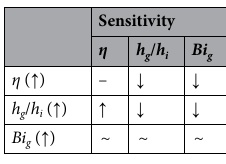
Table 3. Multi-parameter sensitivity analysis results for overall cooling effectiveness. ↑ ( increase ) ↓ ( decrease ) –( no effects ) ~ ( fewer effects